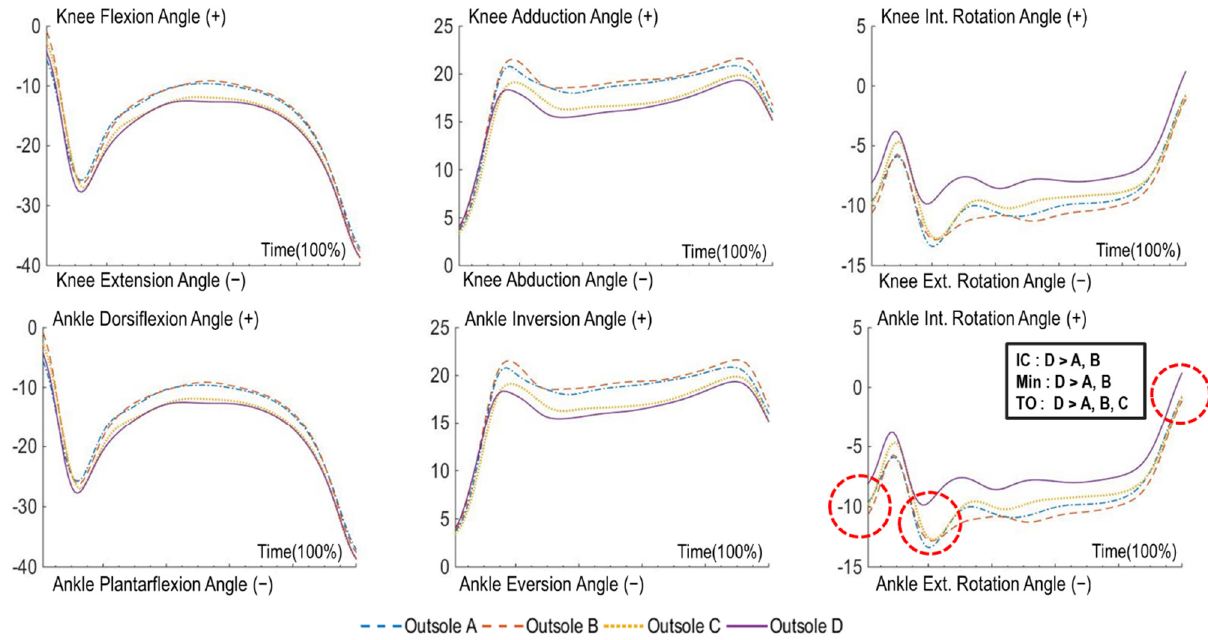
Figure 4. Knee and ankle joints’ angles (mean of 11 participants) upon forward braking motion. IC: initial contact, Min.: minimum joint angle, TO: toe off. (Dotted red circles represent the significant difference among the outsole tread patterns). Table 3. Maximum joint moments upon forward braking motion in a biomechanical analysis.